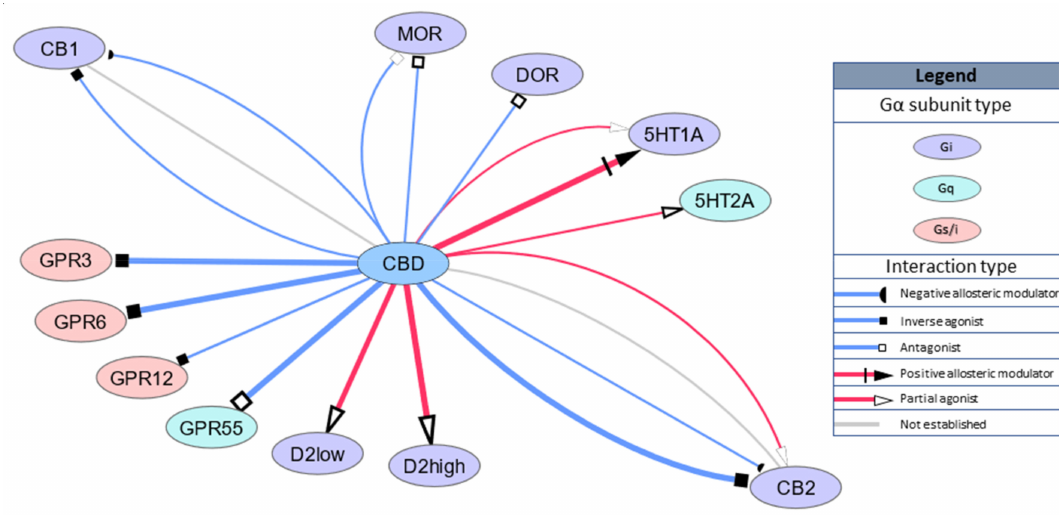
Figure 1. Schematic representation of cannabidiol (CBD) GPCR targets. Width of the edges (lines) represent relative a ffi nity or EC / IC50 for the target (range 11–1000